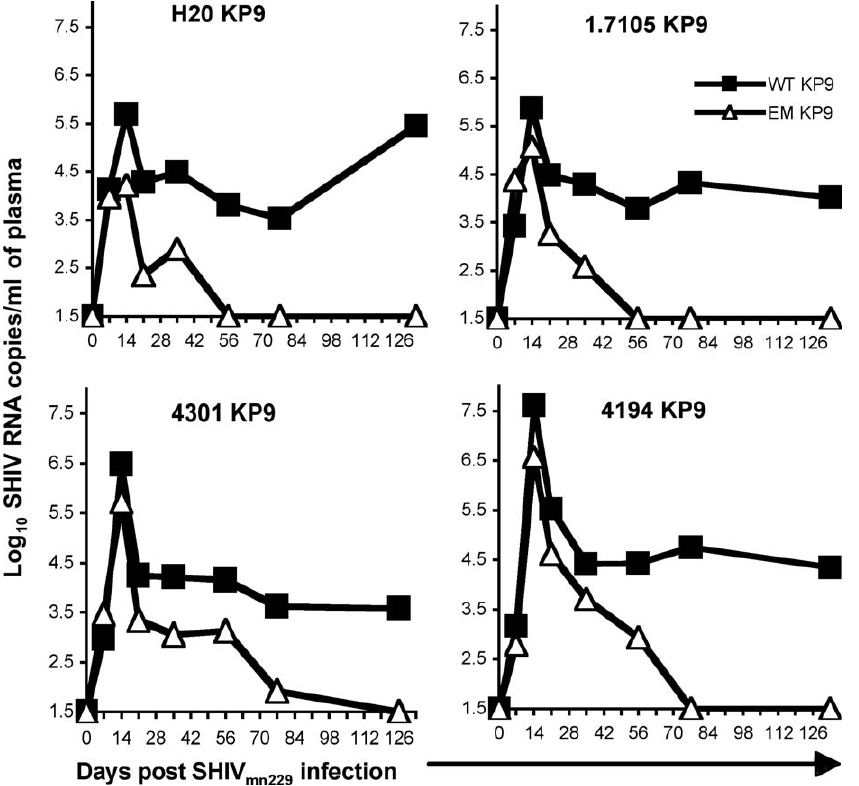
Figure 3. In Vivo Reversion of KP9 Escape Mutant Virus The kinetics of reversion at SIV Gag KP9 was assessed by qRT-PCR from serial RNA samples extracted from plasma in 4 Mane-A*10 negative pigtail macaques infected with the EM KP9 SHIV mn229 reversion (11.2% WT KP9 by